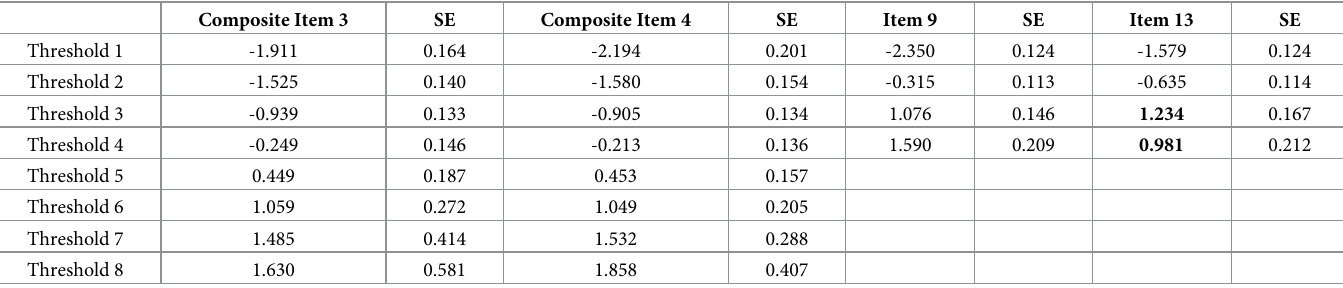
Table 4. Threshold ordering of the positively worded